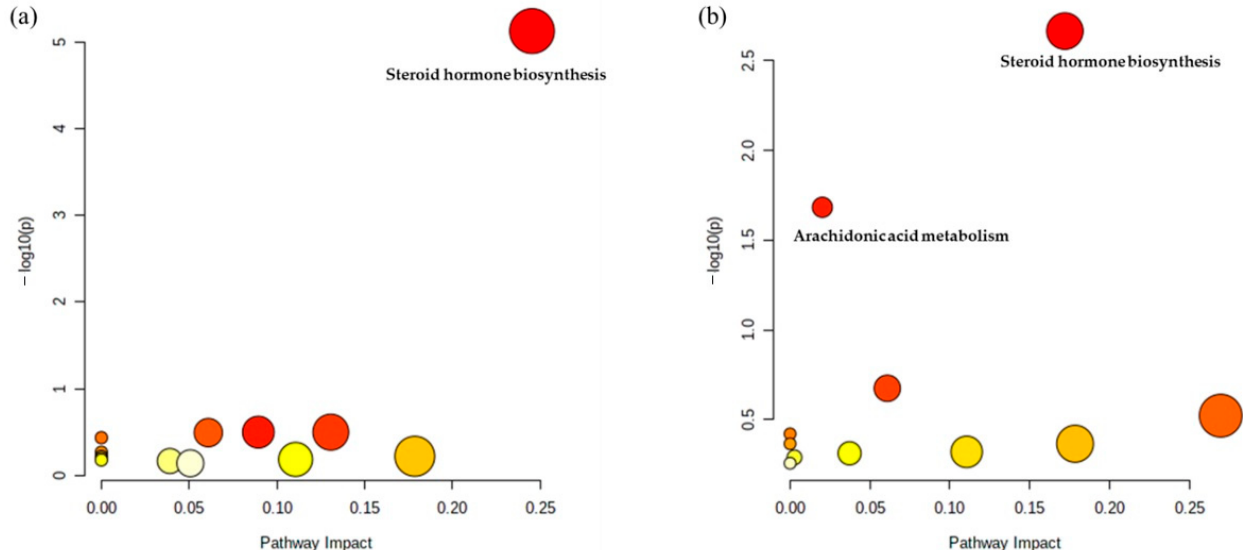
Figure 4. Differentiated metabolic pathways between patient groups and controls can be visually confirmed. Dark red indicates that the pathways were significantly different, with red circles indicating more significance than yellow circles. Light yellow means a less significant than yellow. The Y-axis represents the –log p values, whereas the X-axis represents the pathway impact values. ( a ) Pathway analysis based on 42 metabolites in male groups from an untargeted analysis and ( b ) pathway analysis based on 26 metabolites in female groups from an untargeted